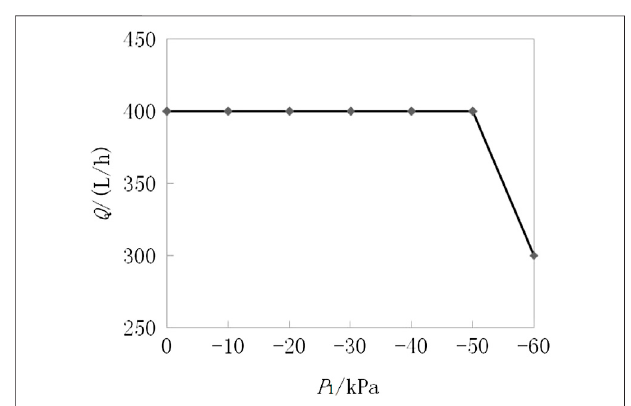
FIGURE 8 | The change of outlet fl ow rate with inlet negative